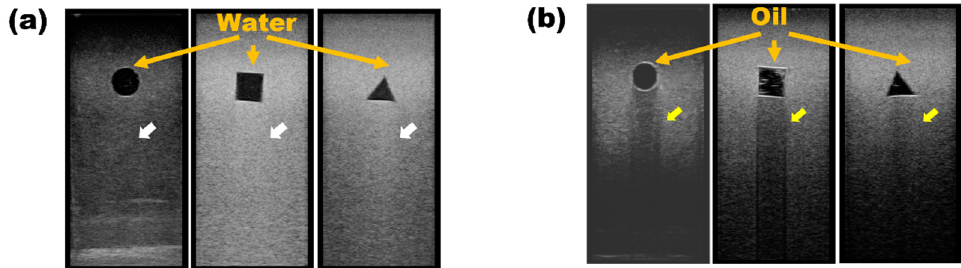
Figure 6. Image characteristics by injected water and oil. ( a ) The white arrows represent posterior acoustic enhancement. The water attenuates and absorbs the ultrasound less than the surrounding gel. ( b ) However, oil with higher acoustic impedance attenuates the ultrasound more than the surrounding gel. This phenomenon is called posterior acoustic shadow, and it represented by the yellow arrows.